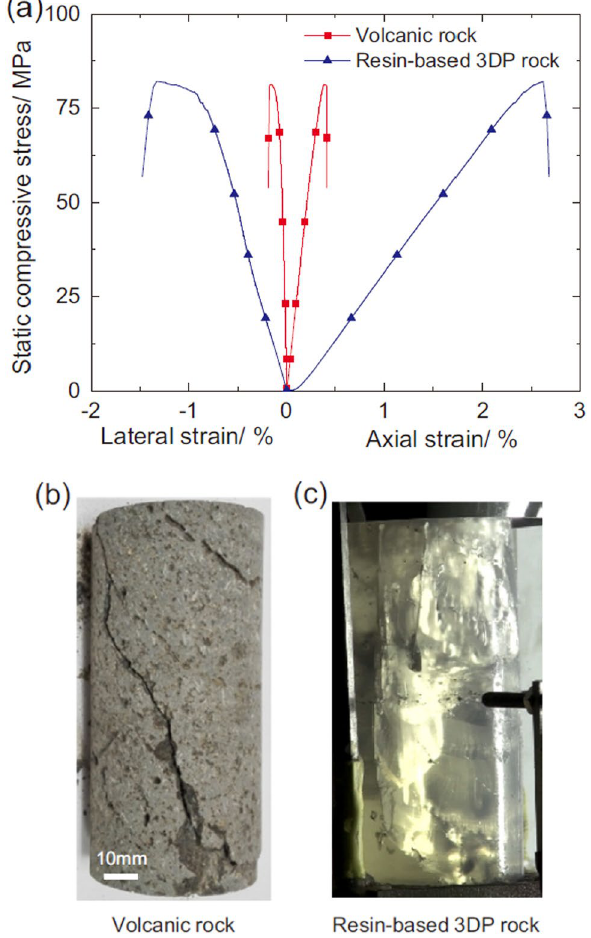
Fig. 9 a Comparison of a stress ‒ strain curves and failure patterns in static uniaxial compression tests of b Volcanic rock and c Resin- based 3DP rock samples (Zhu et al. 2018)